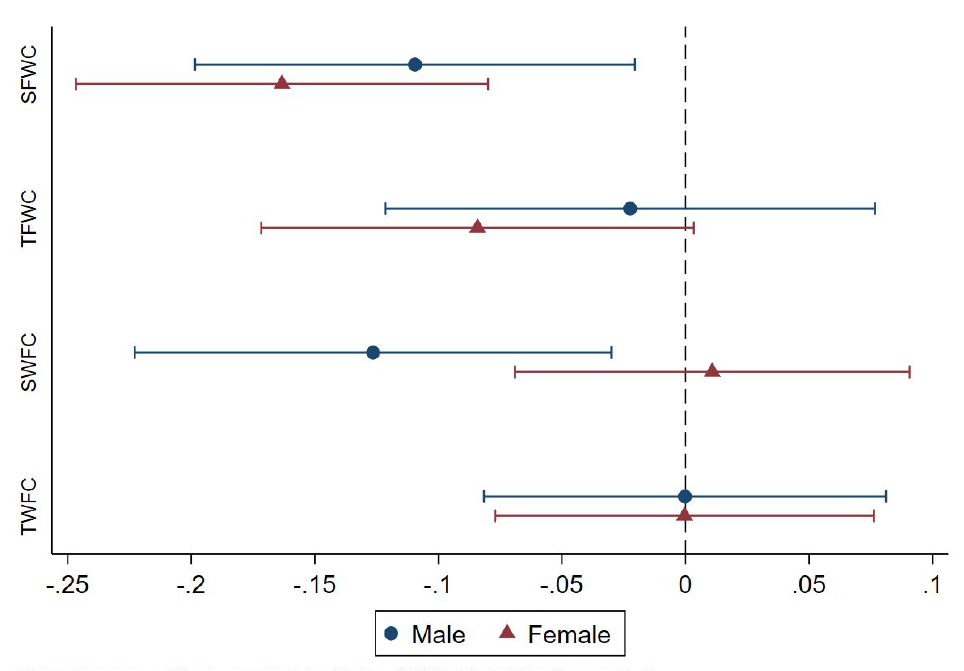
Figure 2 : Standardized effects of partner support on strain and time-related conflicts divided by